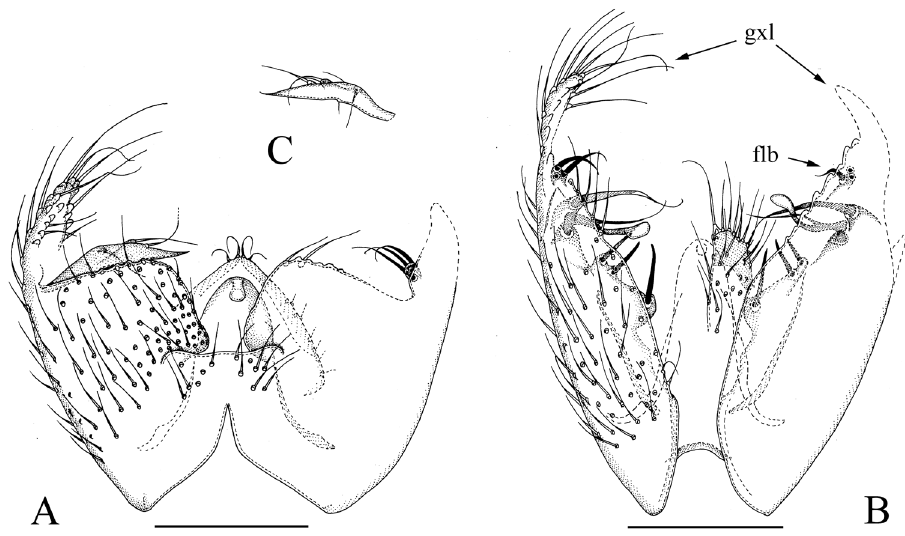
Figure 5. Manota subaristata sp. n. ( A and C holotype B paratype). A Hypopygium, ventral view B Hypopygium, dorsal view C Right gonostylus, ventral view. Scale bar 0.10 mm. Abbreviations: flb = finger-like setigerous lobe, gxl = posterolateral lobe of gonocoxa.